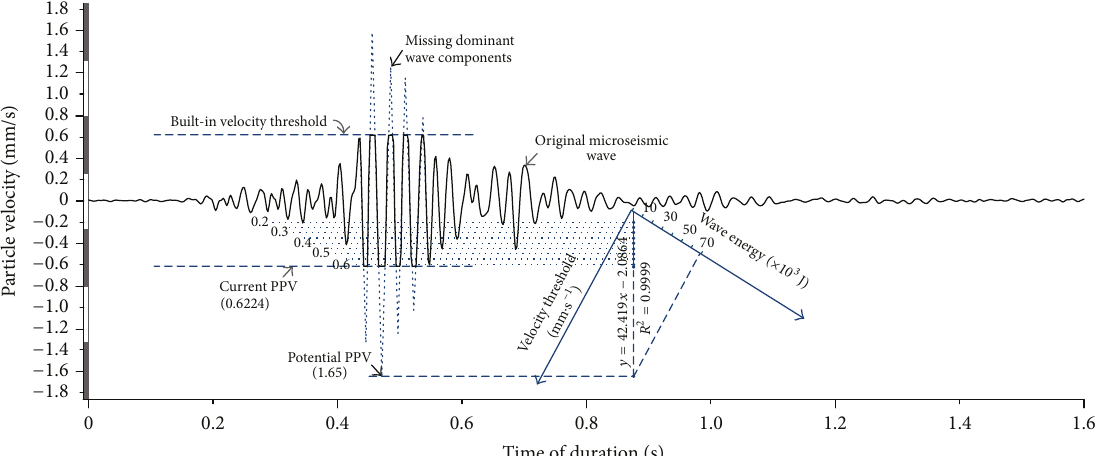
Figure 8: Incomplete measured waveform of thehigh-energy microseismicevent and the potential relationship between residual wave energy and velocity threshold.